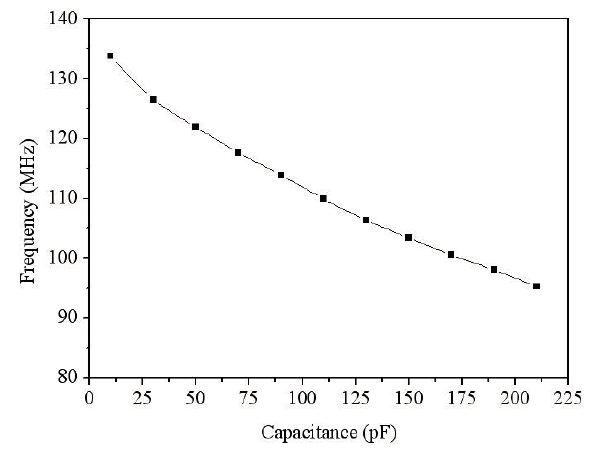
Figure 3. Simulation results of the output frequency for the